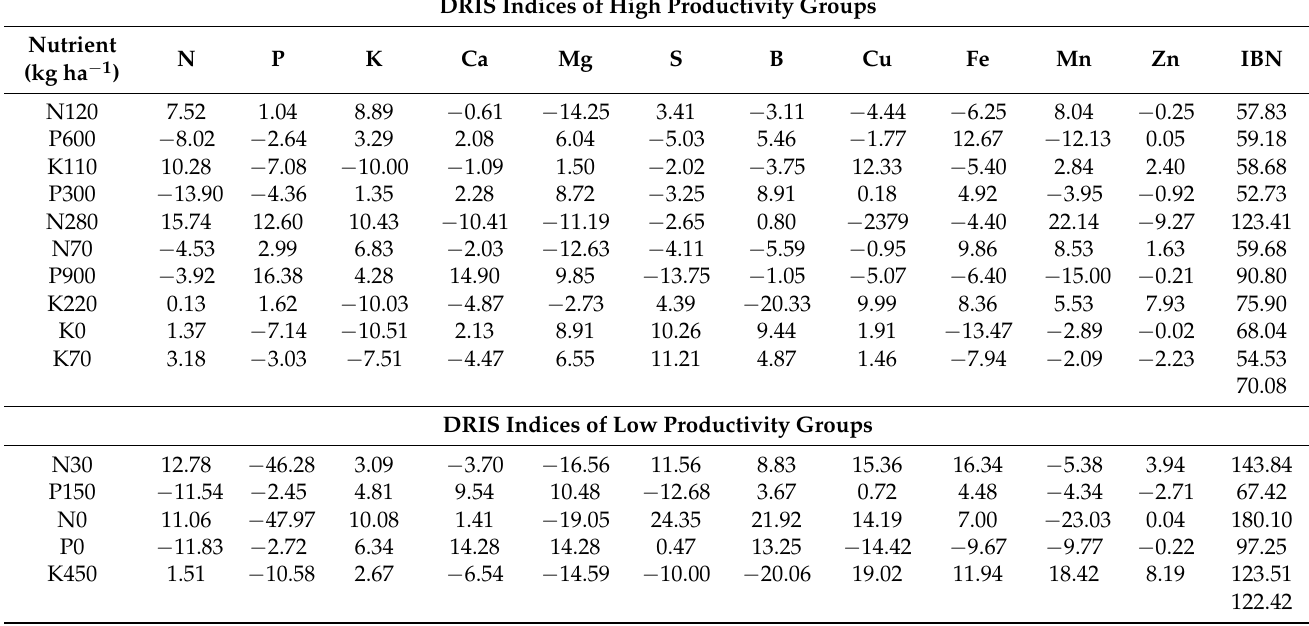
Table 3. DRIS indices for macronutrients and micronutrients in high (>35 t ha − 1 ) and low (<35 t ha − 1 ) productivity potato crops, for the Atlantic cultivar in Una í